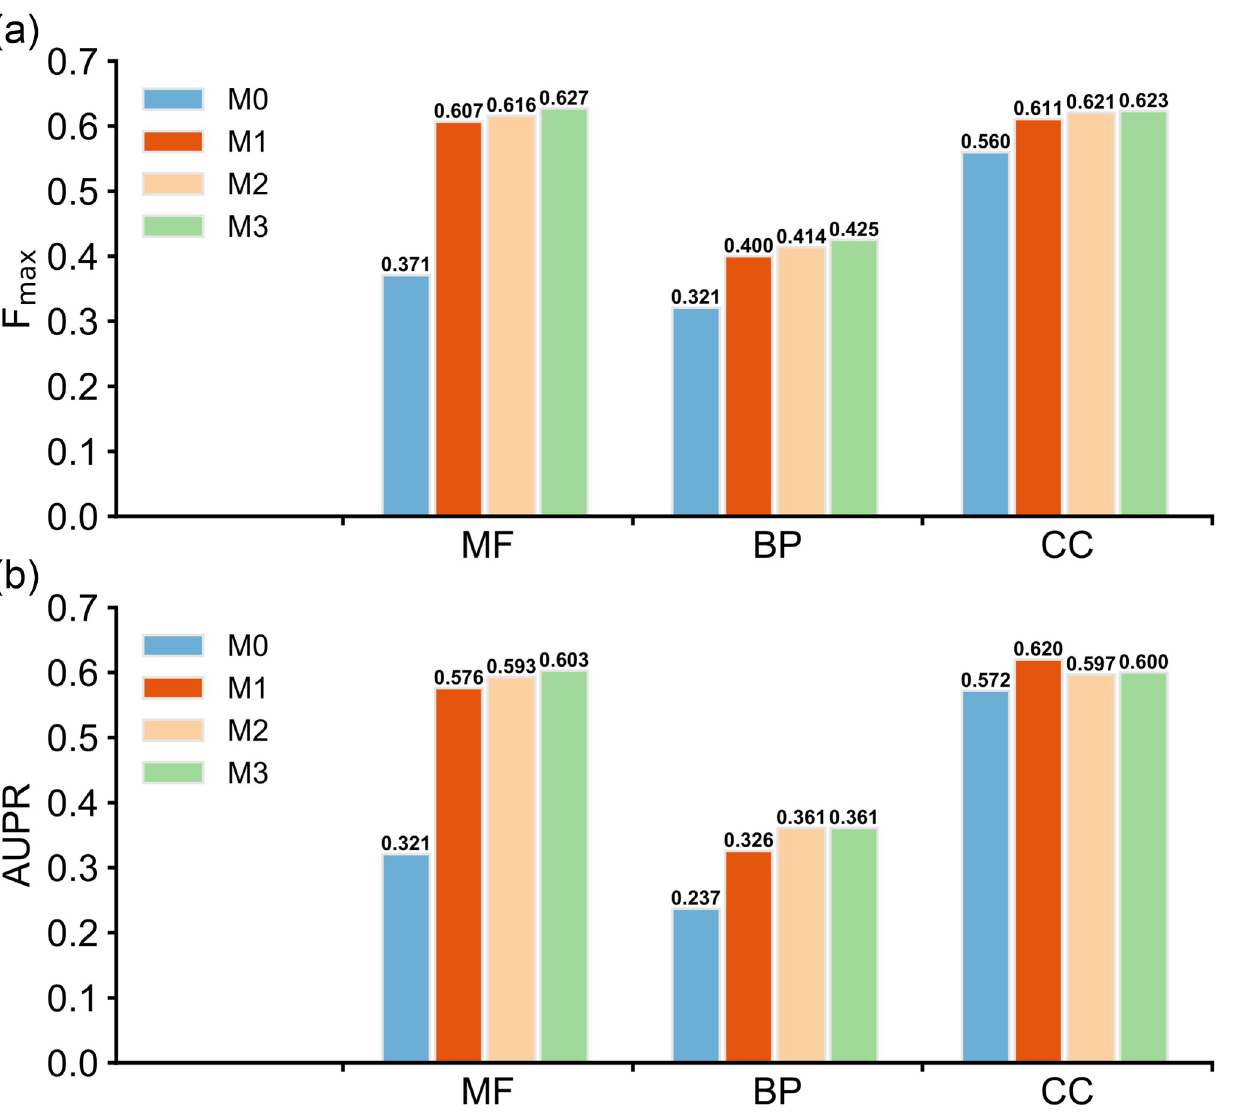
Fig 5. Ablation study on the ATGO pipeline based on 1068 test proteins. M0 denotes the baseline model with one-hot embedding, where M1-3 are the models with transformer embedding, triplet network, and multi-view feature added respectively. (a) The F max values of four models. (b) The AUPR values of four